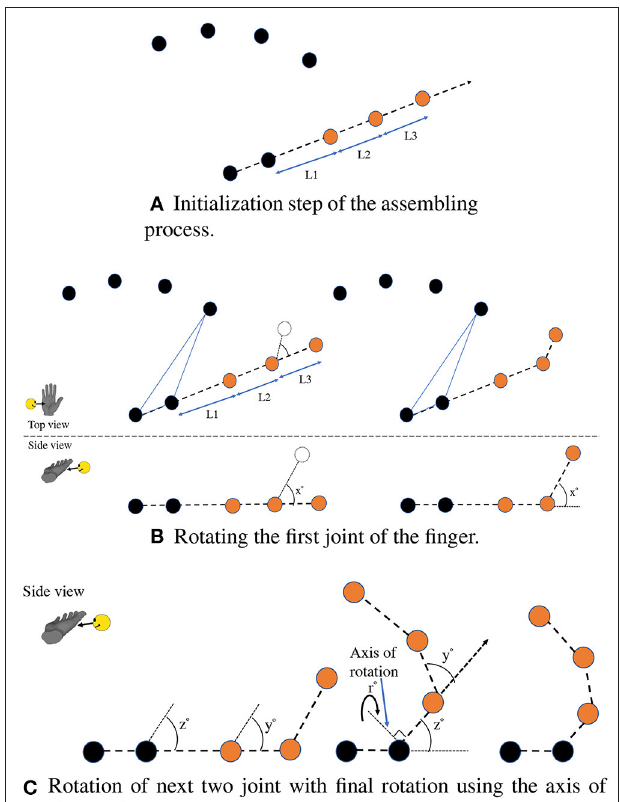
FIGURE 4 | Overall sample process of the assembly to create a thumb of the hand pose. The initialization step shown in (A) uses the 3D positions of the joints directly regressed from the PalmPoseNet and then uses the root joint with the CMC joint to extrapolate a 3D line. The three joints are then placed on this line, and the length of each segment between the joints is taken from the LengthNet. The tip joint is first rotated using the axis, which passes the